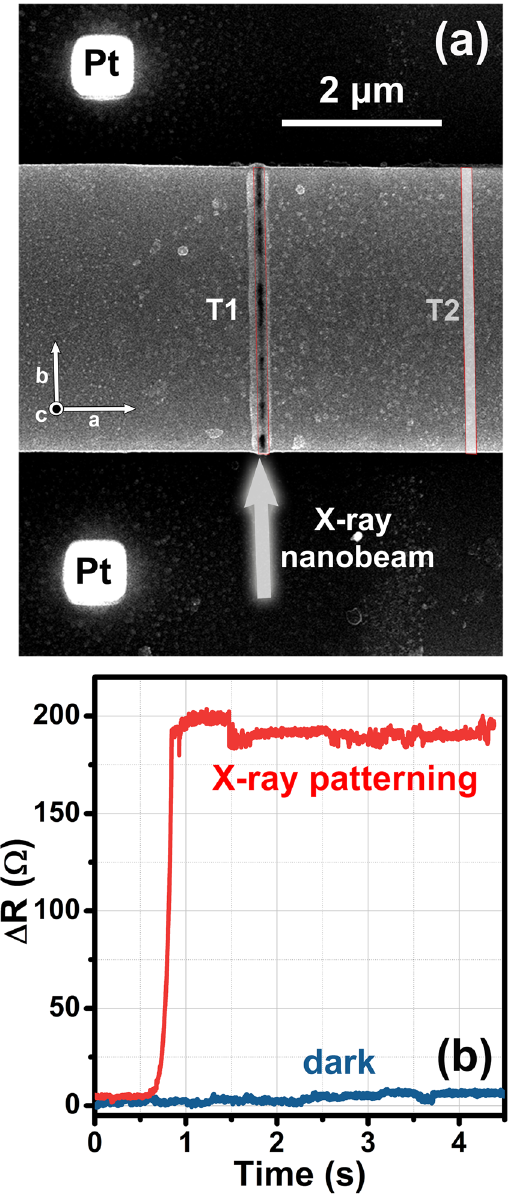
Figure 3. ( a ) SEM image of the Bi-2212 micro-crystal after X-ray irradiation. The white arrow represents the X-ray nano-beam, parallel to the [0 1 0] crystallographic direction, employed to write the two trenches highlighted by red contours. The area irradiated to realize the first trench (T1) is clearly visible, while the area patterned for the second trench (T2), located in the bottom part of the crystal (see also Fig. 2), is highlighted by a white rectangle. ( b ) Variation of the electrical resistance of the sample measured on-line during the X-ray exposure to write the T1 trench (red curve). The blue curve represents the initial sample resistance immediately before the X-ray nanopatterning procedure: its behaviour is indicative of the environmental electrical noise in the on-line measurement